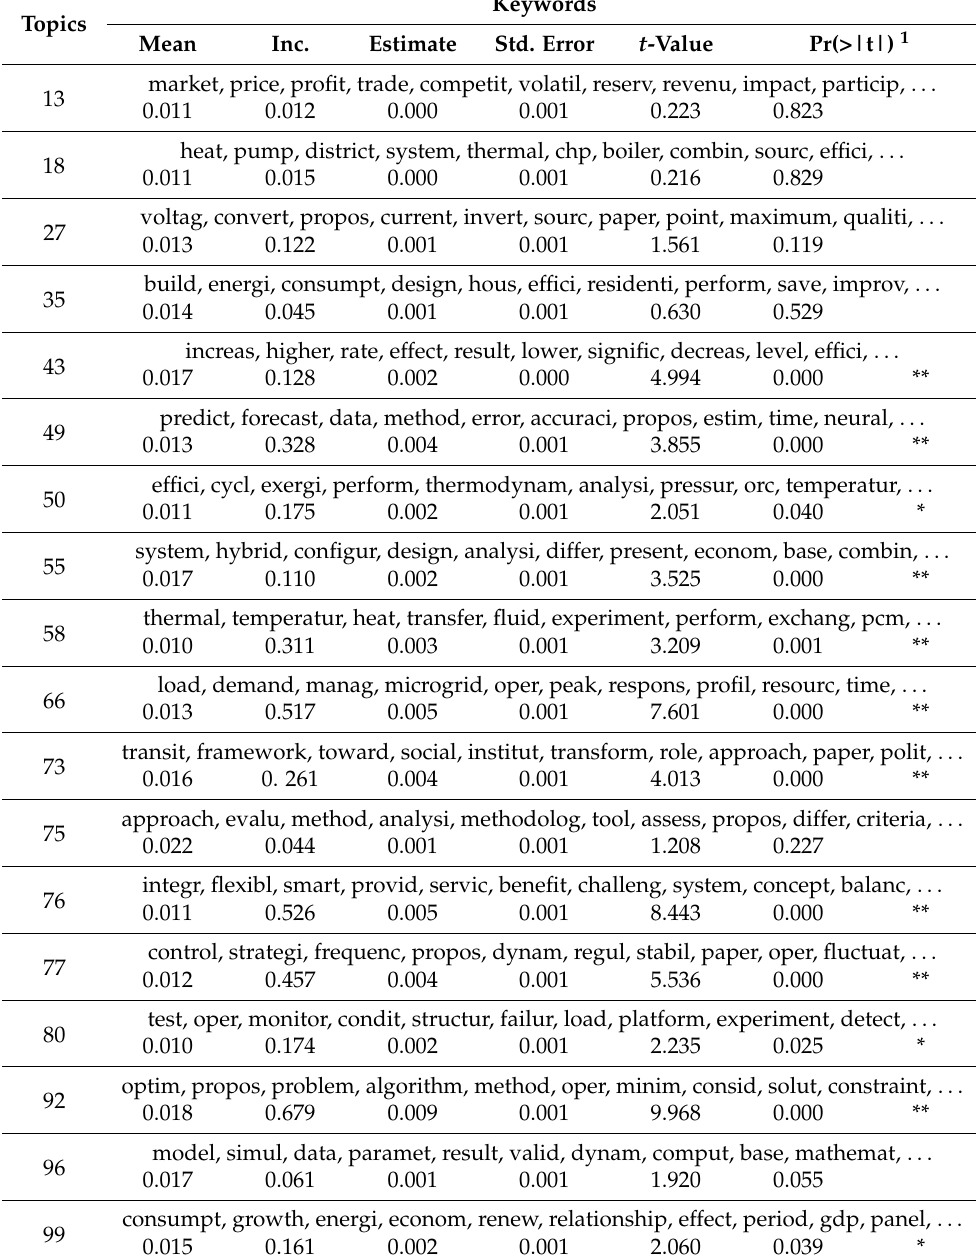
Table 3. Topics selected as strong